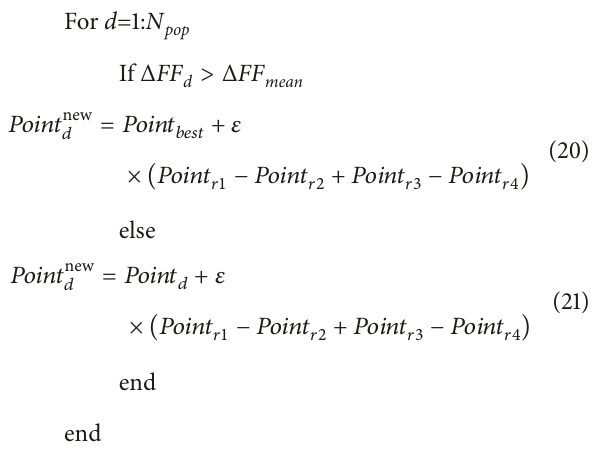
Algorithm 1. New solution search strategy for the first and the second update processes of